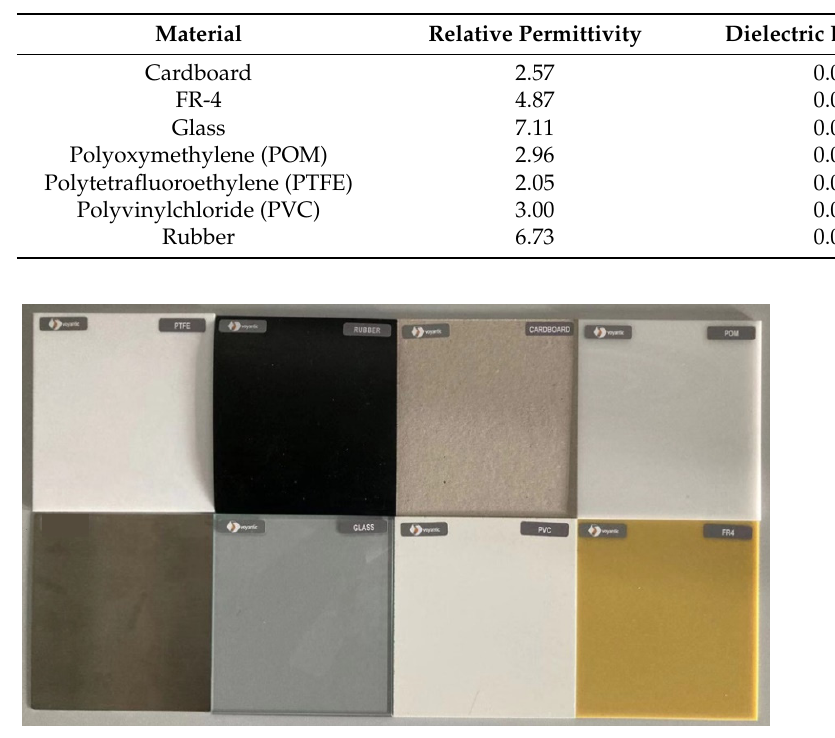
Figure 3. Photo of the materials used for experimental